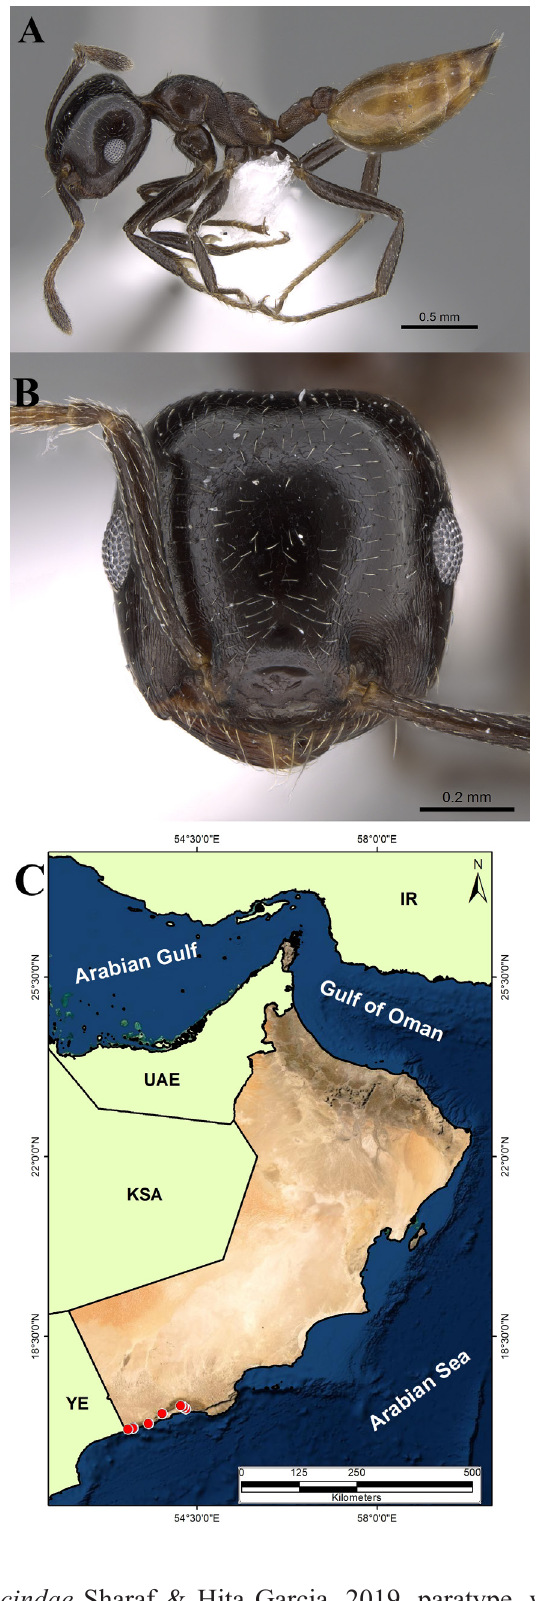
Fig. 32. Crematogaster jacindae Sharaf & Hita Garcia, 2019, paratype, worker (CASENT0922856, AntWeb.org (Michele Esposito)). A . Body in profile. B . Head in full-face view. C . Distribution